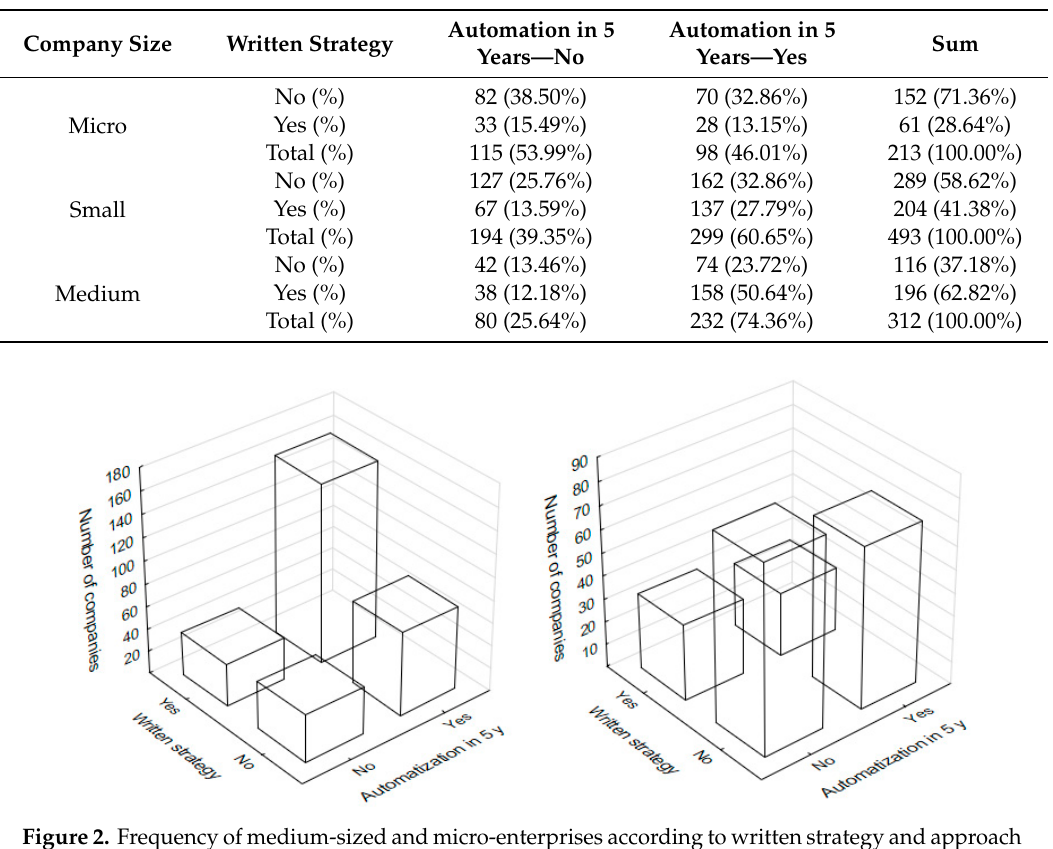
Figure 2. Frequency of medium-sized and micro-enterprises according to written strategy and approach to implementation of automation in 5 years. Medium-sized on the left, micro-sized enterprises on the